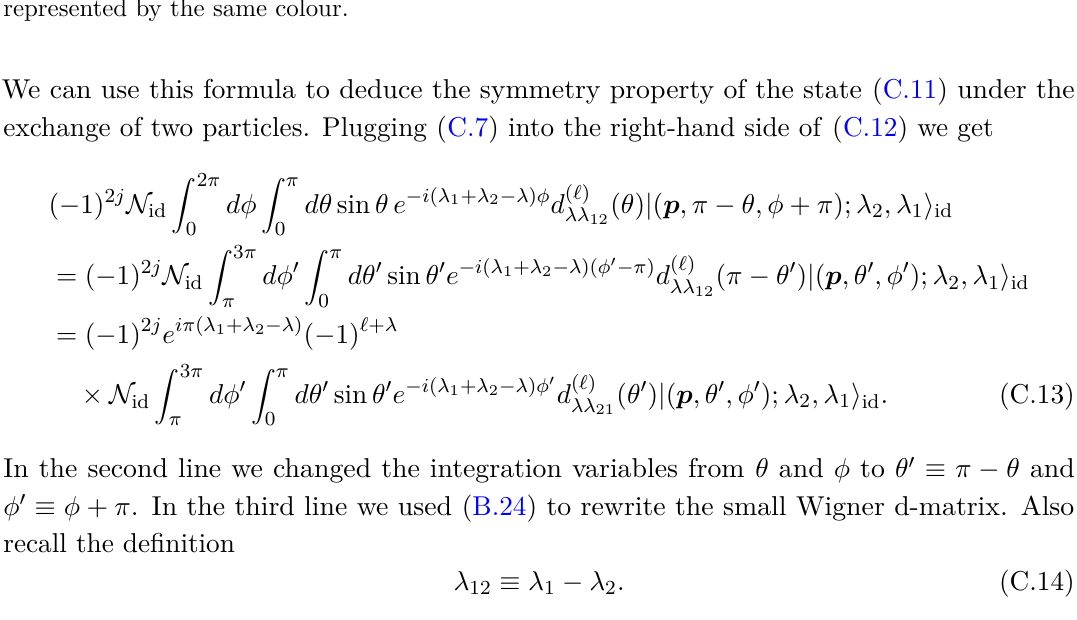
Figure 10 . The geometric picture behind (C.9). The particles are identical and are therefore represented by the same